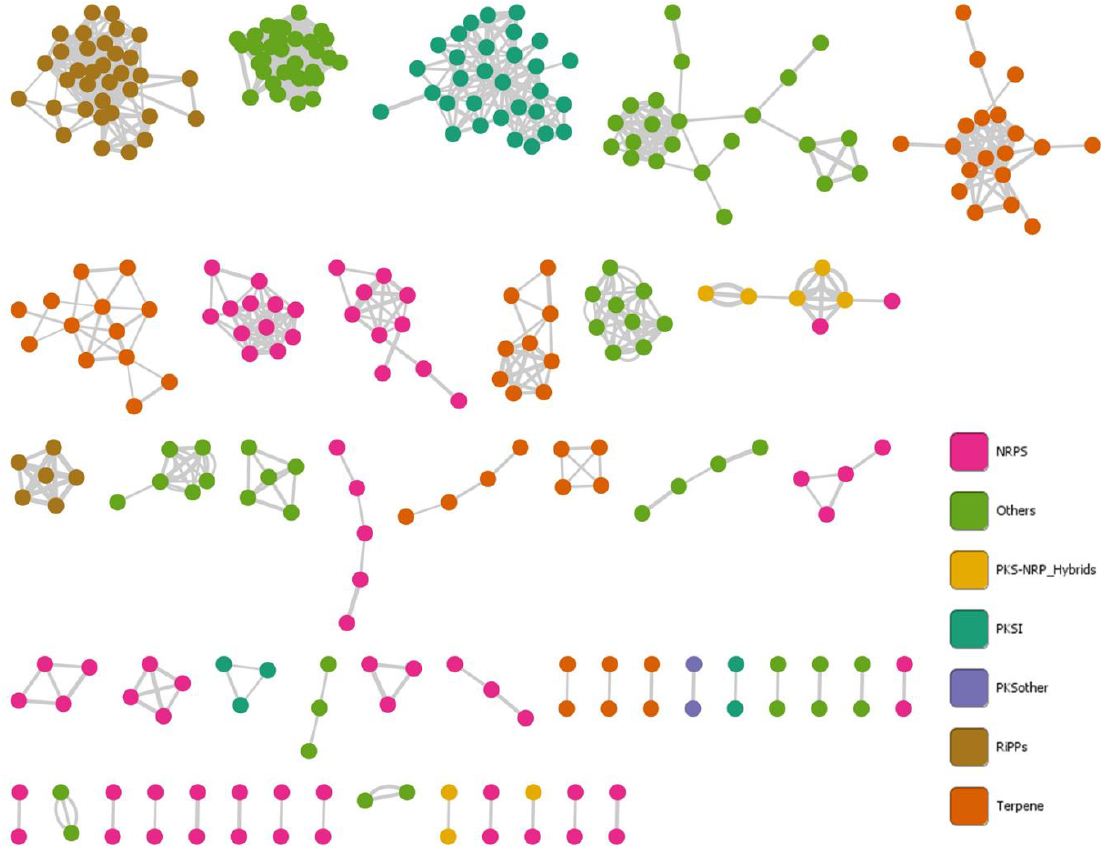
Figure 11. Molecular networks of predicted BGCs in genomes of the genus Gordonia . Each node represents a BGC and colors to BGC class. The similarity matrix among BGCs was calculated using BiG-Scape, and the final networks were edited in Cytoscape v3.9.1. A complete and detailed list is available in Table S12.